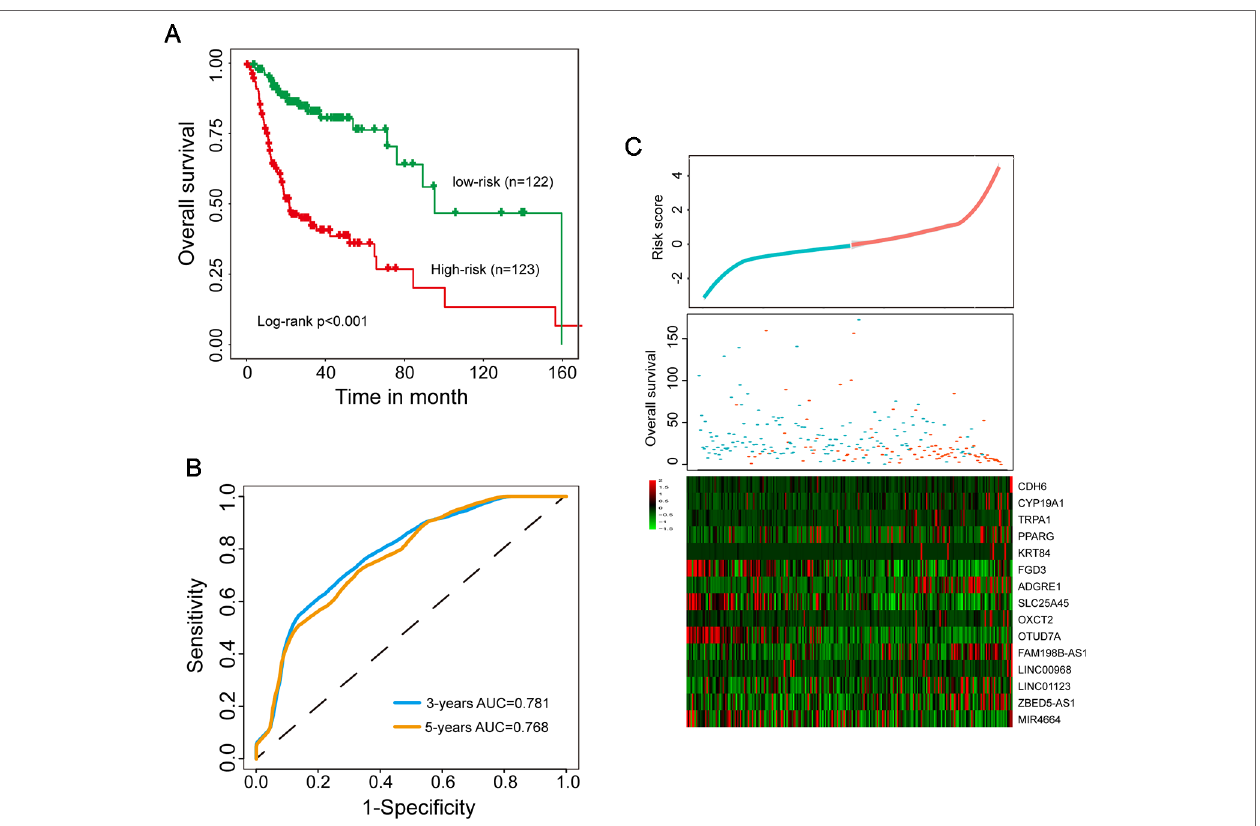
FIGURE 2 | Development and evaluation of the 15SigRS in the discovery data set. (A) Kaplan – Meier survival curves of overall survival between the high-risk group and low-risk group. (B) Time-dependent receiver operating characteristic (ROC) analysis at 3 and 5 years. (C) The distribution of risk scores and survival status of patients and expression patterns of 15 prognostic genes in the